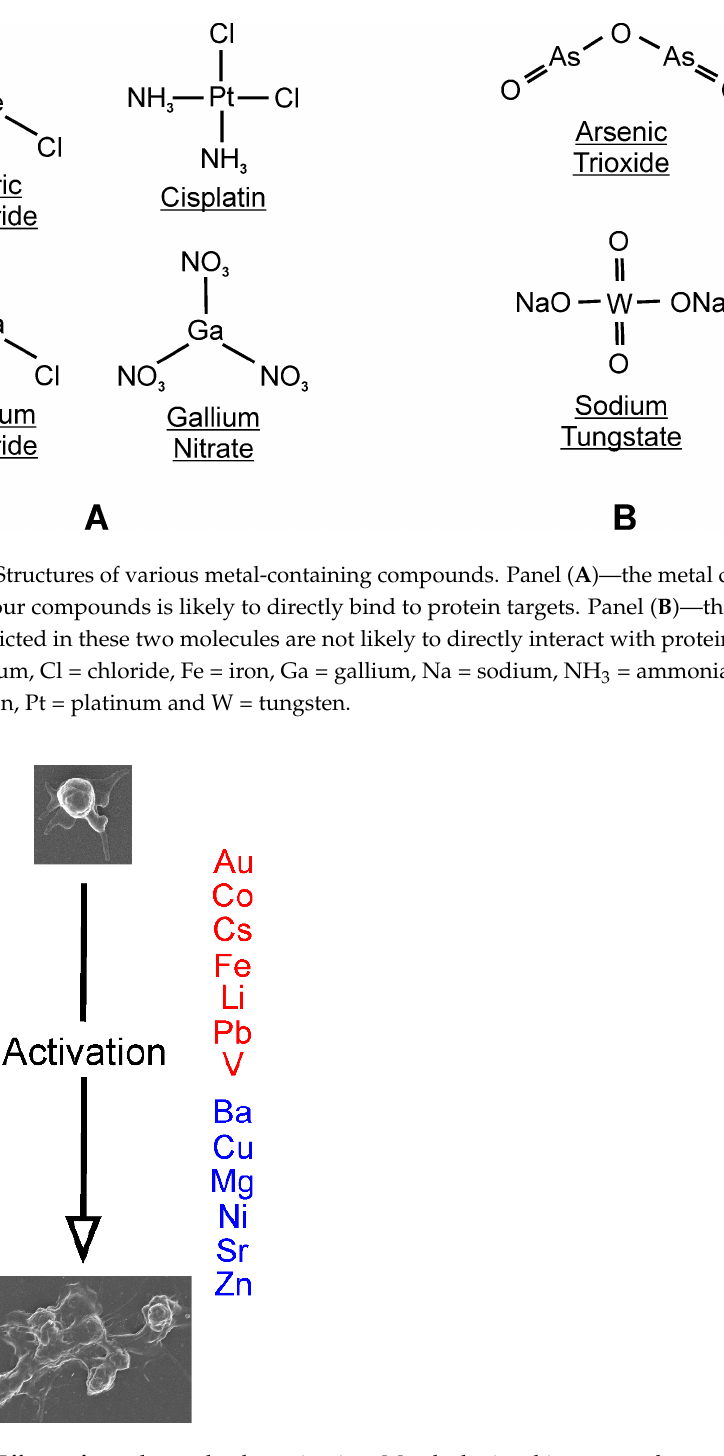
Figure 3. Effects of metals on coagulation. Metals depicted in green enhance coagulation, those dis- played in red decrease clotting, and elements that are blue have conflicting effects on coagulation that may be concentration-dependent or dependent on the species source of the plasma or blood. Metals seen at the top of the figure with the * are those without a specific site in the coagulation pathways identified. All metals have been defined in the text, but the depiction of iron was changed to improve the visual presentation. Fe +2 = Fe(II) and Fe +3 = Fe(III). Please refer to the text for greater details about the specific coagulation enzymes and pathways depicted.